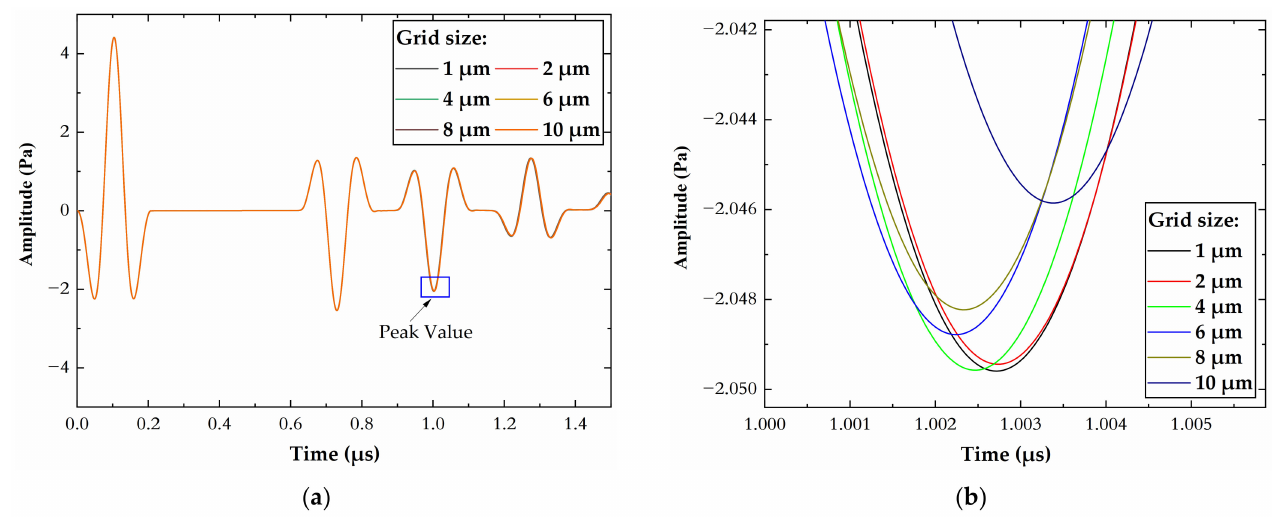
Figure 3. Simulation results of different grid sizes when the bead height is 10 µ m: ( a ) Echo signals. ( b ) Partial enlarged view of reflected wave at the top of ice layer.